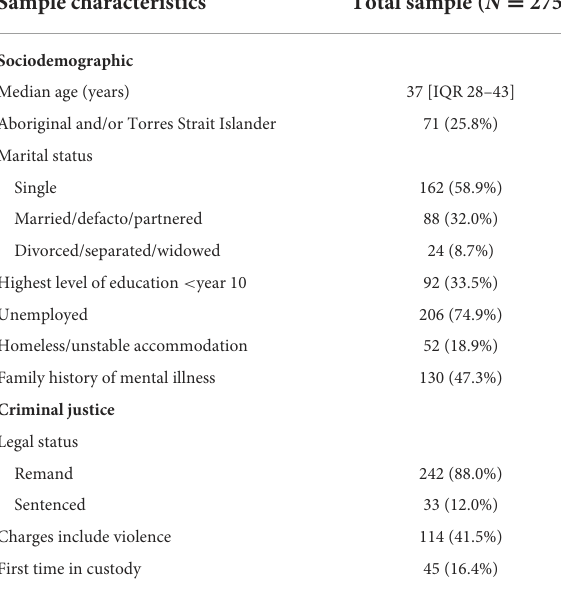
TABLE 1 Sociodemographic and criminal justice characteristics of the interviewed sample at baseline. Sample characteristics